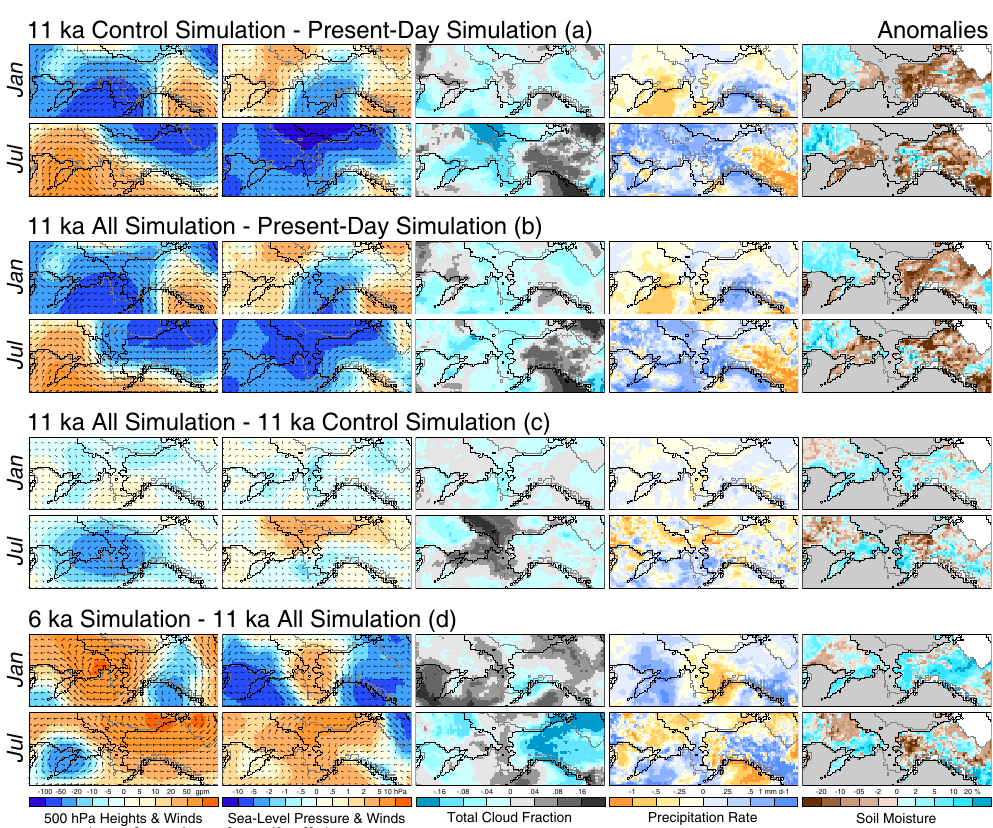
Figure 10. Atmospheric circulation (500hPa heights and winds, sea-level pressure and surface winds), clouds, precipitation and soil-moisture anomalies. (a) 11ka Control minus Present Day ; (b) 11ka All minus Present Day ; (c) 11ka All minus 11ka Control ; (d) 6ka minus 11ka All (showing the change between 11 and 6ka). Ice-sheet and coastal outlines as in Fig.